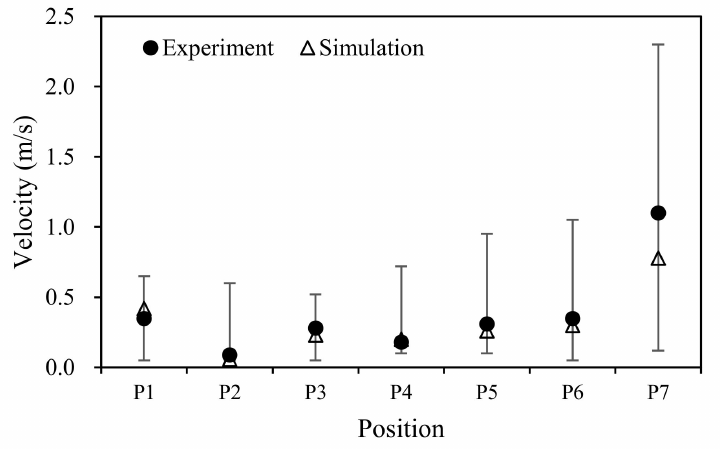
Figure 8. Comparison of the average measured and simulated wind velocity values at points